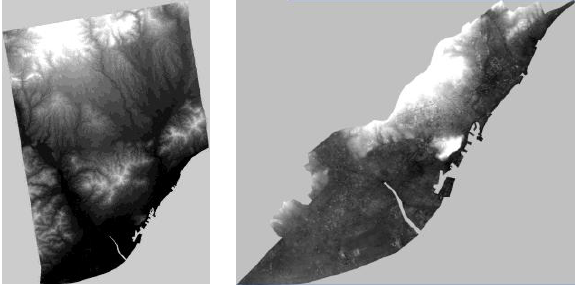
Figure 3. TSX DSM (Left: Large Area, Right: Urban Area)